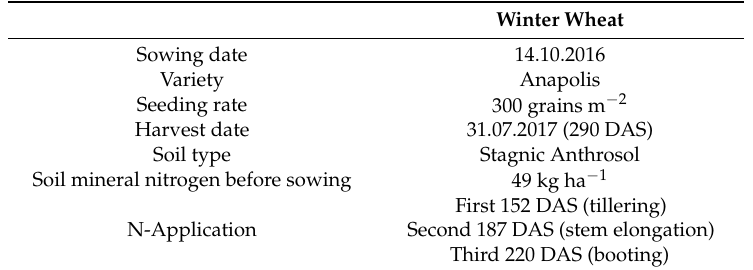
Table 1. Crop management experimental season 2016/2017. DAS: days after sowing.